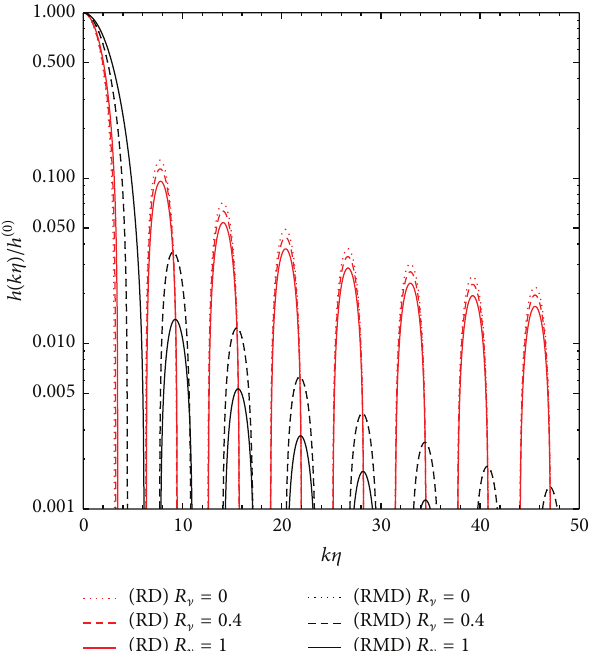
Figure 1: Evolution of the normalized wave amplitude ℎ 𝑖𝑗 /ℎ (0) 𝑖𝑗 as function of 𝑘𝜂 for RD (red lines) and RMD (black lines) background cosmic inventories. Results are for vanishing anisotropic stress, with = 0 (dotted lines), for 𝑅 = 0.4052 (dashed lines) and for 𝑅 ] ] = 1 (solid lines). The RD curves are scale independent so that 𝑘𝜂 𝑅 ] is given in units of 𝑘𝜂 0 . The RMD curves are correctly interpreted = 1 , which correspond to scales that have by observing that 𝑘𝜂 eq entered the Hubble horizon at the time of matter-radiation equality (see also Figure 7 for comparison). In spite of being more evident for the RMD scenario, in both situations the largely increasing values of 𝑅 ] result in a more relevant suppression of the tensor modes during the cosmological evolution. Notice that just for the first peak, solid lines are overpassing dashed- and